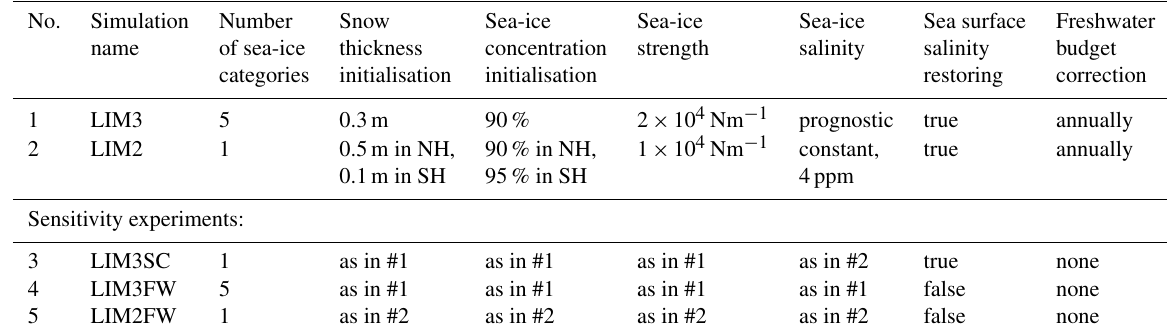
Table 1. NEMO3.6-LIM simulations analysed in this study. No. Simulation Number Snow Sea-ice of sea-ice thickness concentration